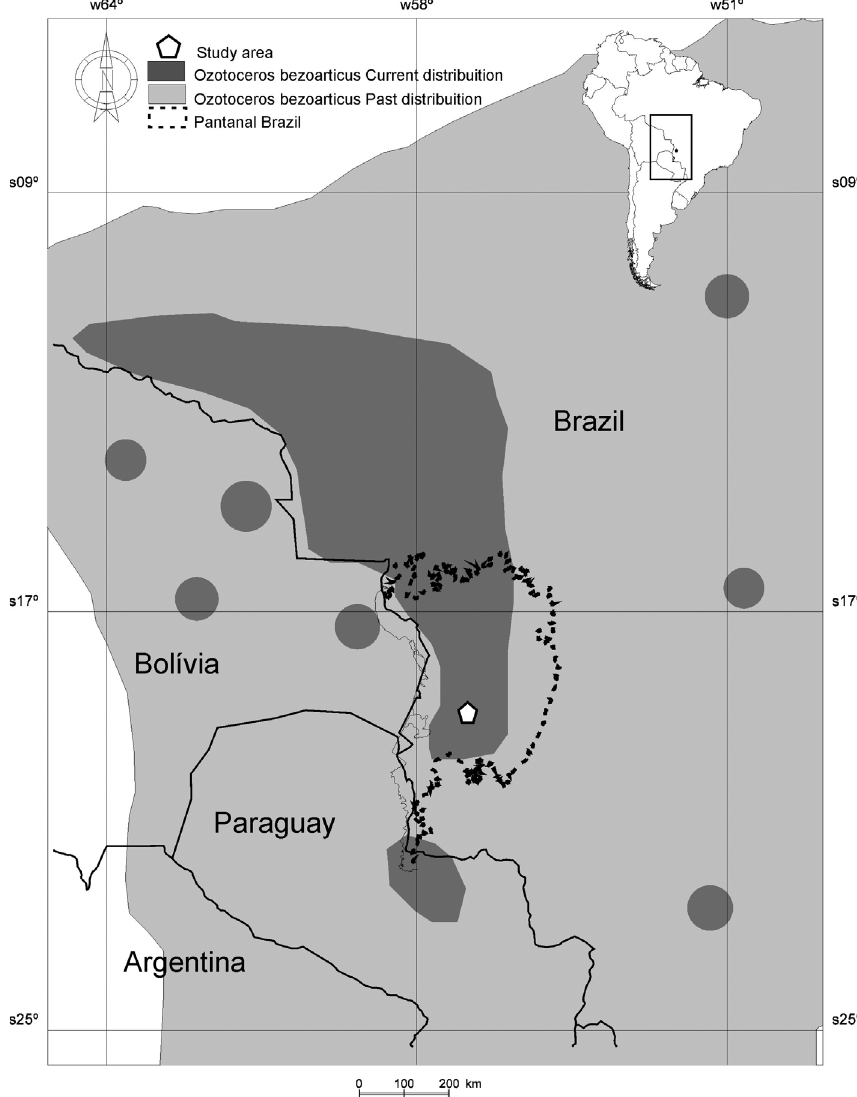
Figure 1 - Map showing the past and current distribution of the pampas deer and the predominant distribution in Brazil. The location of the population studied in this work is